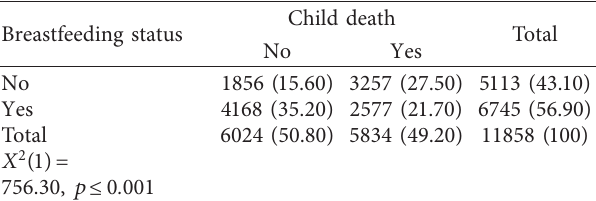
Table 10: Breastfeeding status on child mortality.